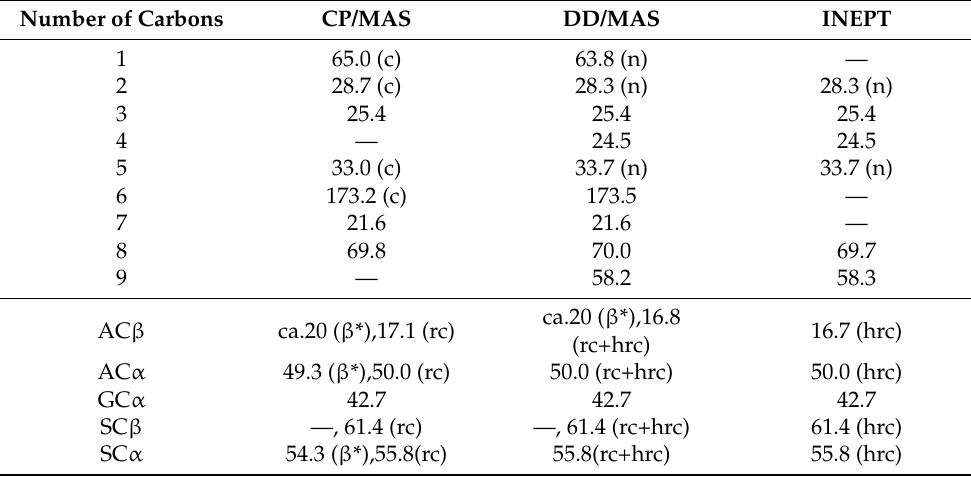
Table 1. 13 C chemical shifts (ppm) of 13 C CP/MAS, 13 C DD/MAS, and 13 C r-INEPT NMR spectra of Sample II in the hydrated state together with the